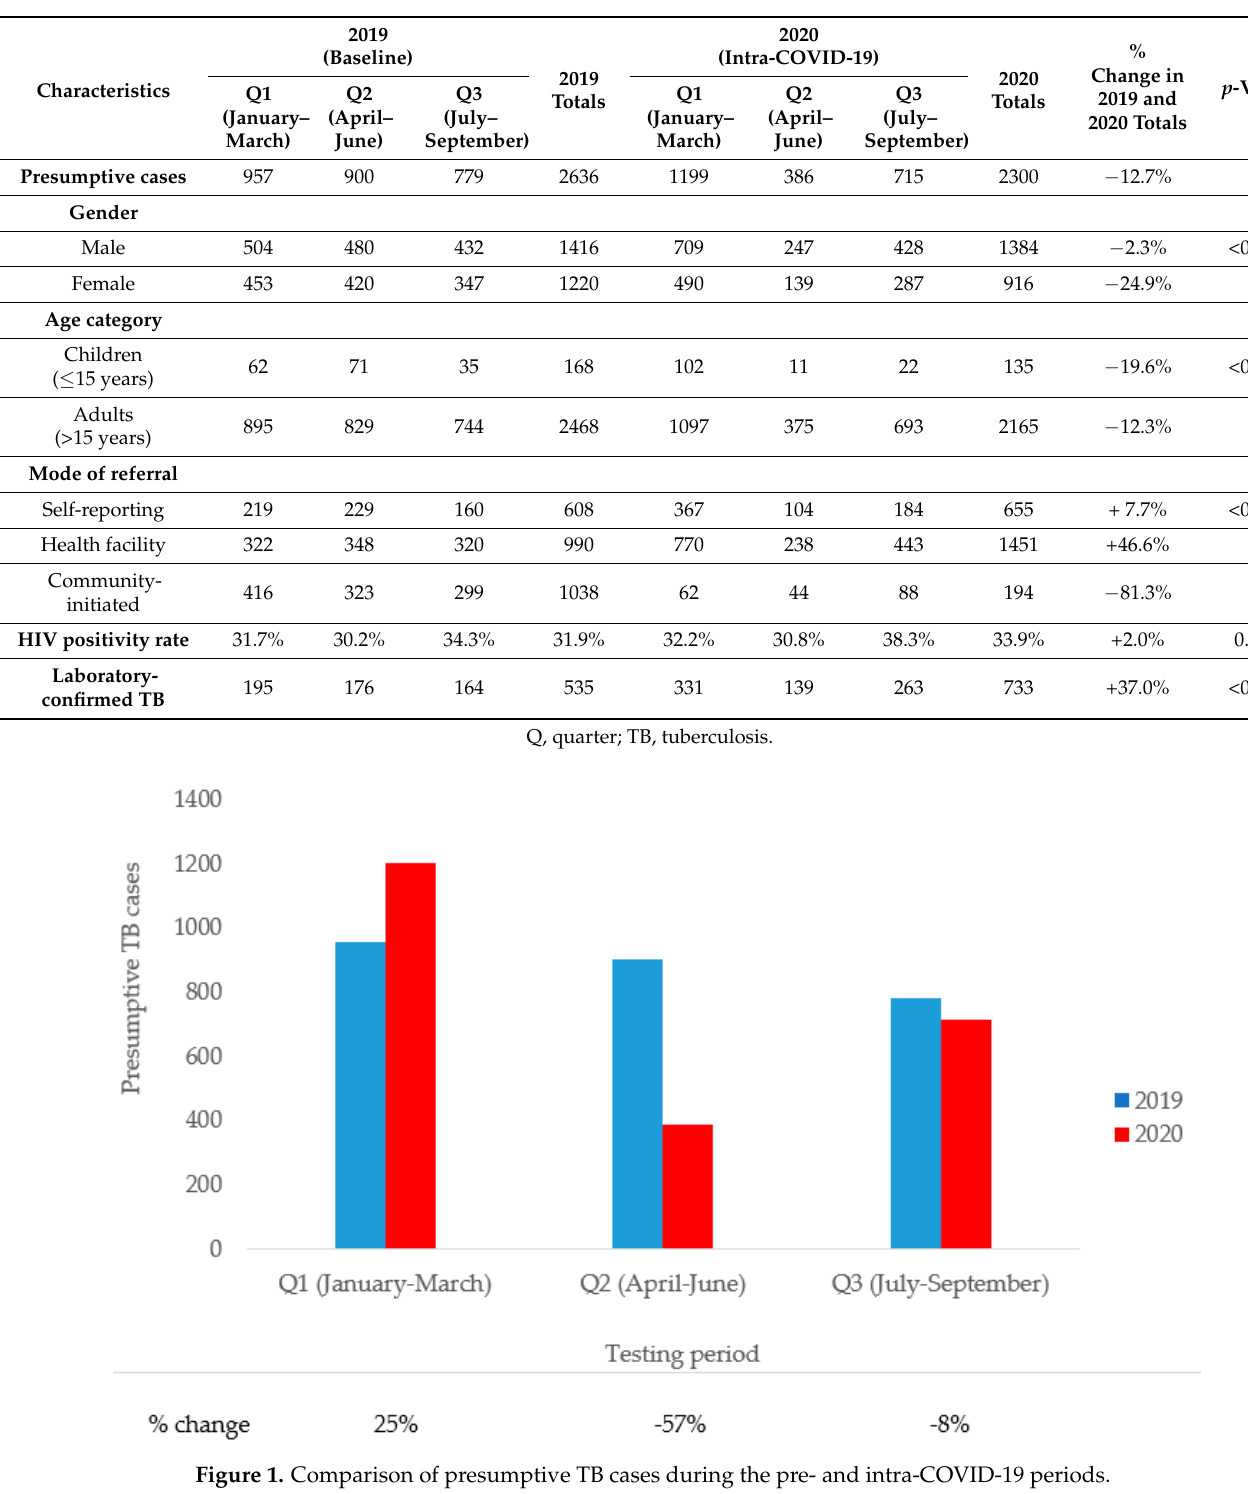
Figure 2. Trends in monthly presumptive TB cases during the pre- and intra-COVID-19 periods.